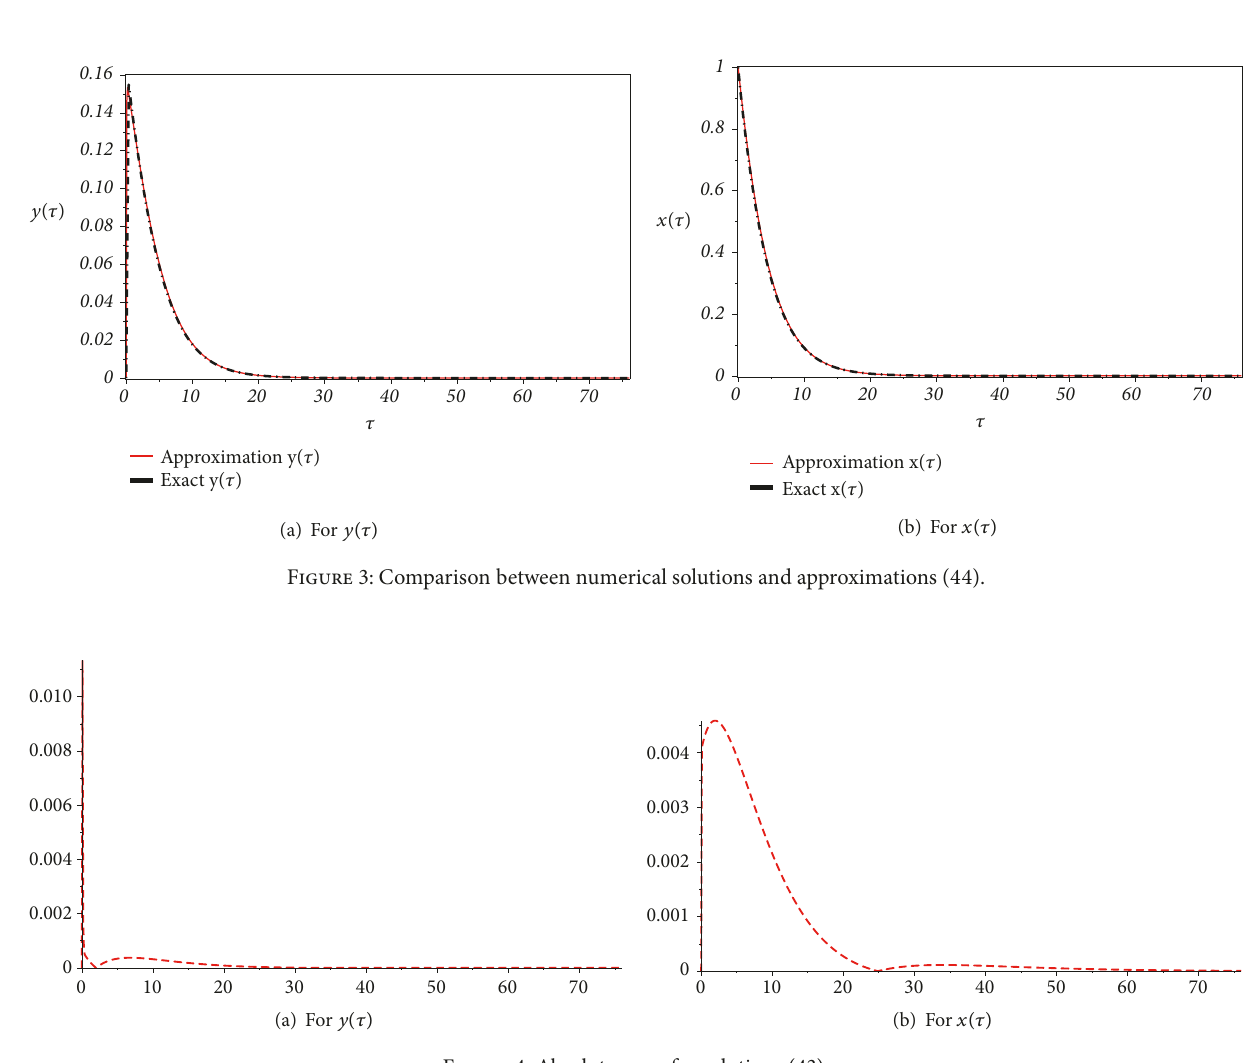
Figure 2: Comparison between numerical solutions and approximations (43).